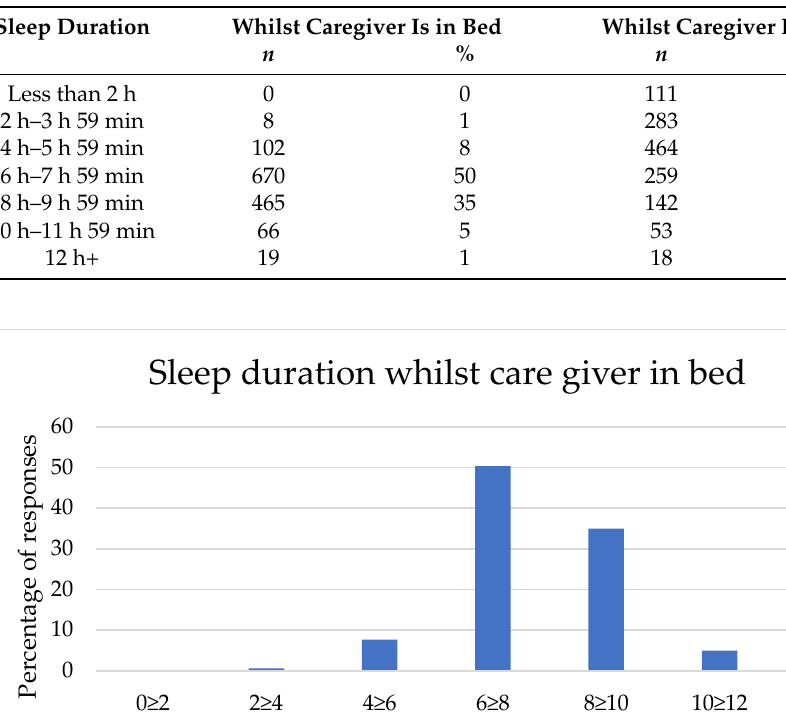
Table 1. Caregiver-reported duration of sleep that their dog achieves whilst the caregiver is either in bed or out of bed.